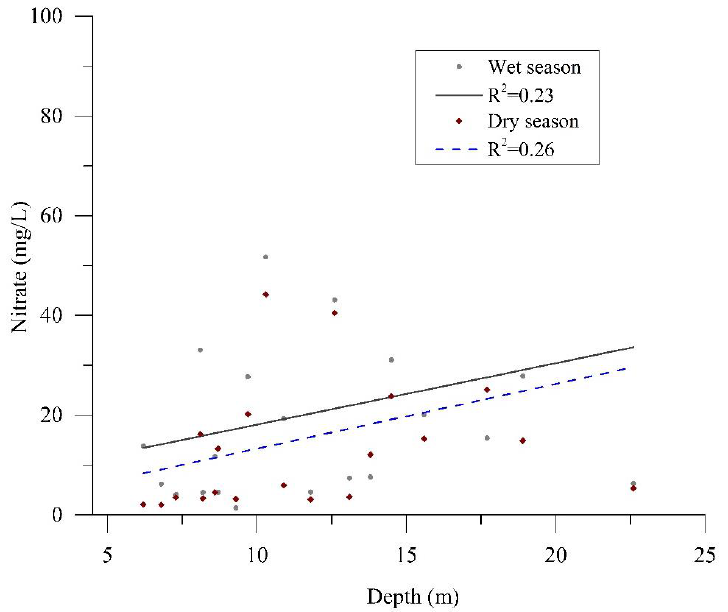
Figure 6. Nitrate variation with